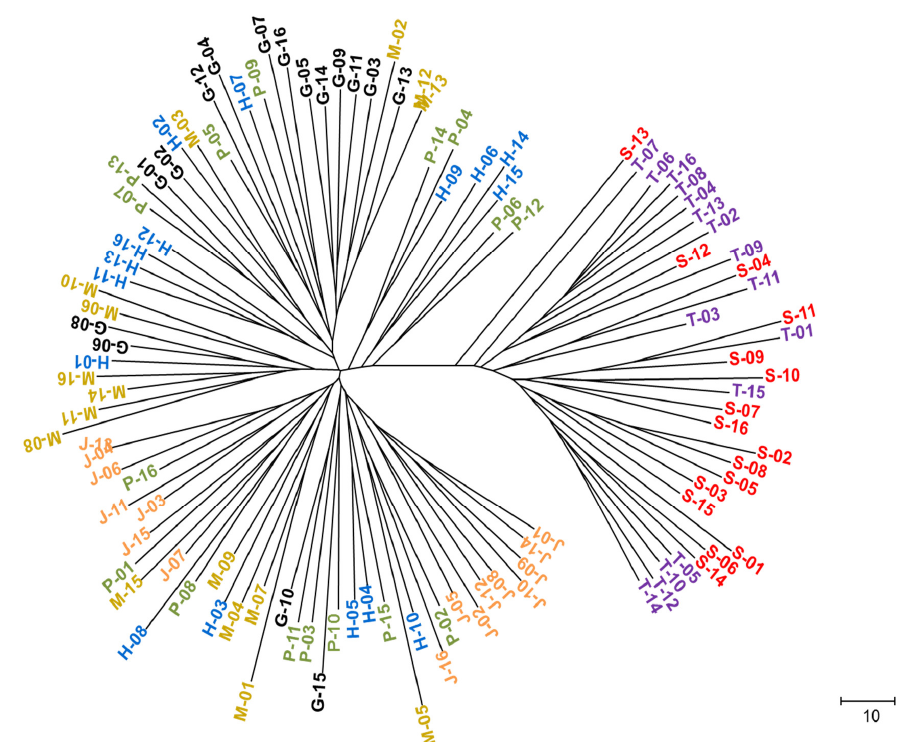
Figure 2. The evolutionary relationships of the cultivars according to the neighbor-joining method drawn using MEGA6. The branch lengths indicate the evolutionary distances within the phylogenetic tree.